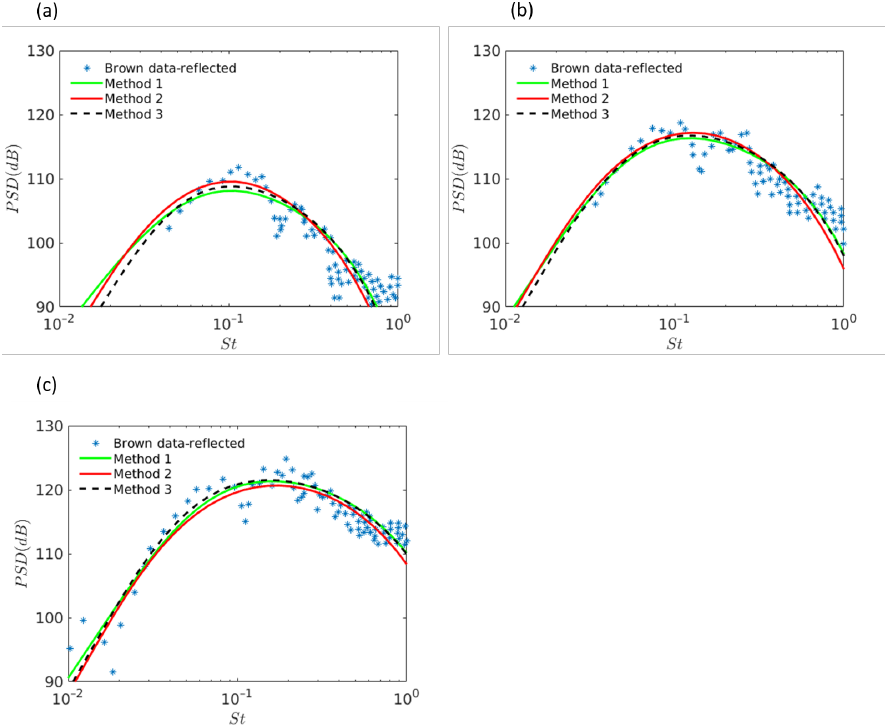
Figure 12. Comparison of the acoustic predictions for methods 1, 2 and 3 using Particle Swarm Optimization ( a ) Ma = 0.5 ( b ) Ma = 0.7 ( c ) Ma =